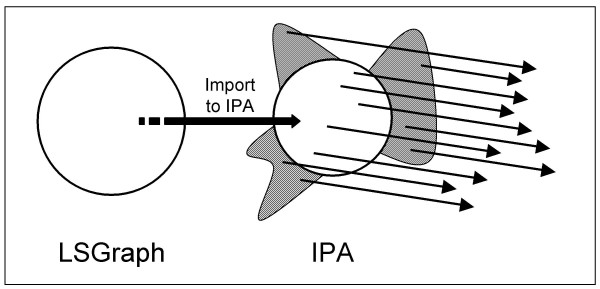
Transfer of entities between two knowledge bases. For LSGraph, PubMed and GO, all extracellular or membrane-bound entities cited in scientific abstracts were exported using UniProt accession numbers into IPA (thick arrow) for each cancer type. For IPA, imported entities were recognized and enlarged by functional neighbors (shaded area) of «Global Analysis Genes» network. All entities with «High Level Function» corresponding to «cancer» (thin arrows) were exported to Microsoft Excel workbook as hit lists for further individual examination (see Additional file 1).